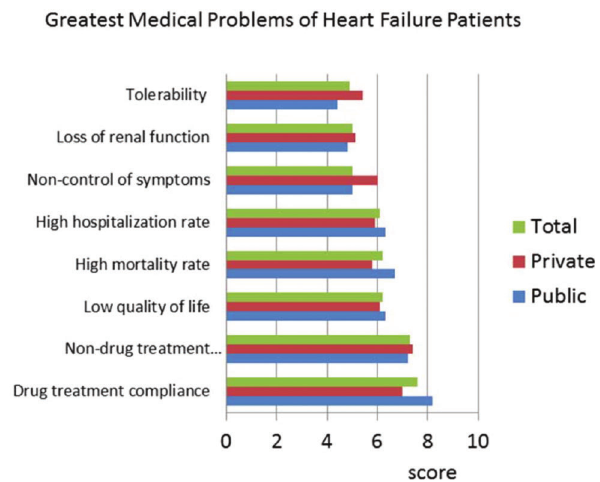
Figure 3 - Perceptions of doctors in centers treating heart failure (HF) regarding the greatest medical problems of HF patients using a score for total, private, and public